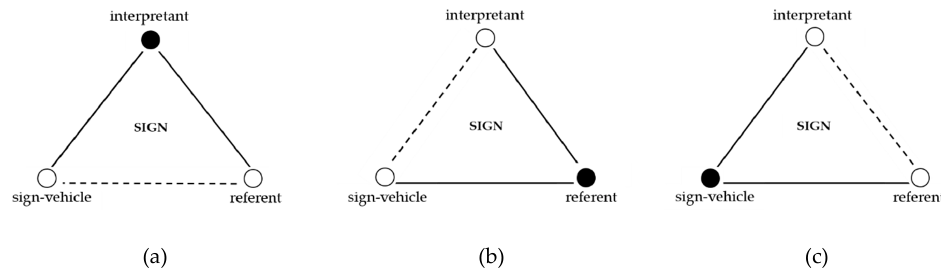
Figure 1. Illustration of the triadic sign relation, known as the semiotic triangle , considering ( a ) the interpretant as mediator, ( b ) the referent as mediator, and ( c ) the sign-vehicle as mediator [12,15]. Cartographic research on semiotics, which focuses on the interpretant as mediator, emphasize the role of a mutually shared set of codes established between the cartographer and the percipient, by